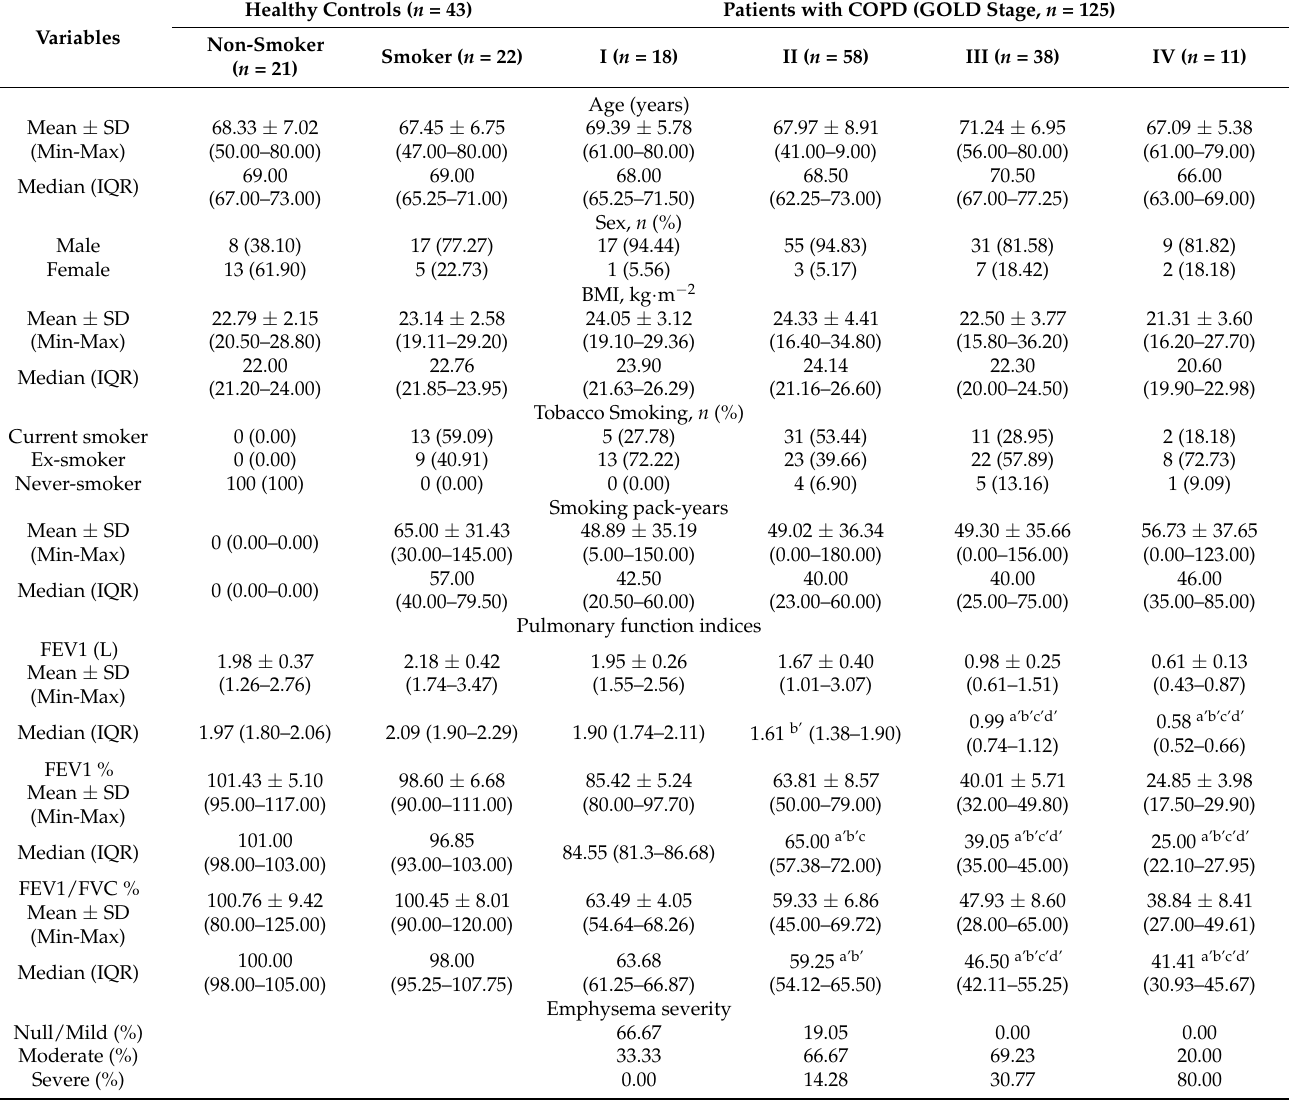
Table 1. Baseline characteristics of our cohort of healthy and COPD participants ( n =